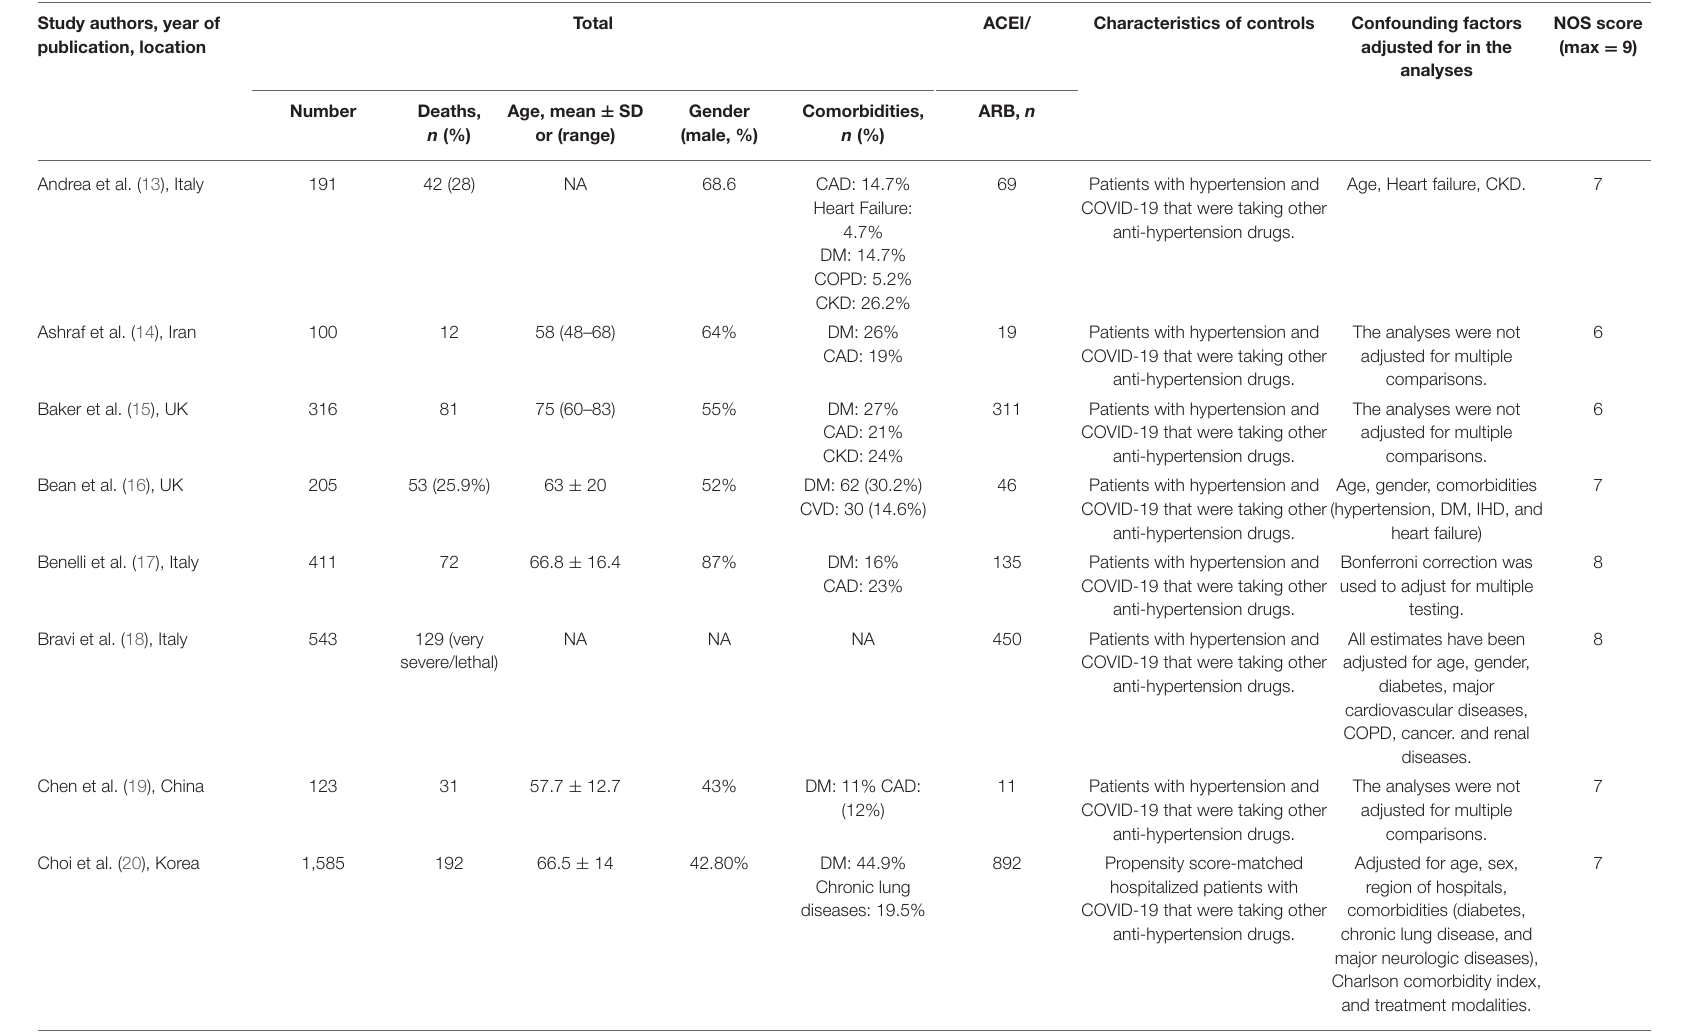
TABLE 1 | Baseline characteristics of patients assessed in the studies included in the